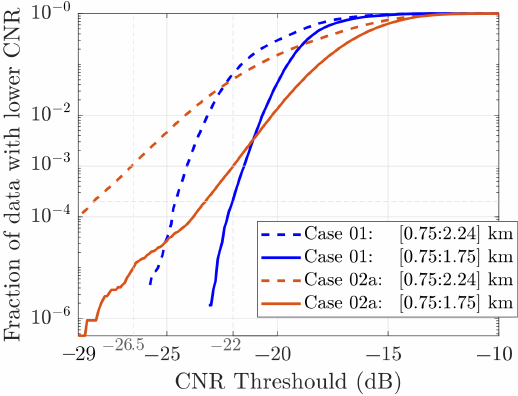
Figure A1. Cumulative distributions of Carrier-to-Noise-Ratio (CNR) occurrences below the thresh- old. Cases 01 and 02a depicted with full or limited f-LOS